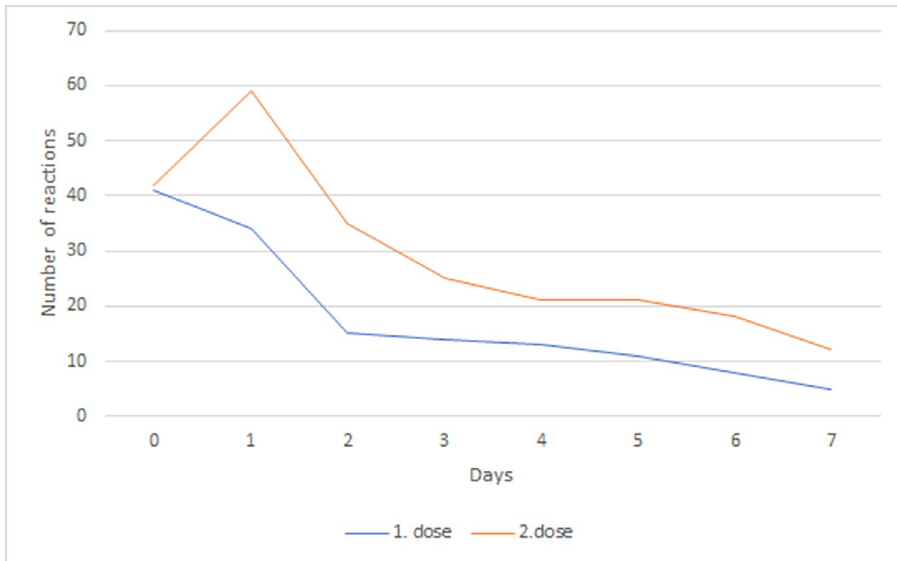
Fig 4. General adverse reactions after SARS-CoV-2 vaccination—development in time.